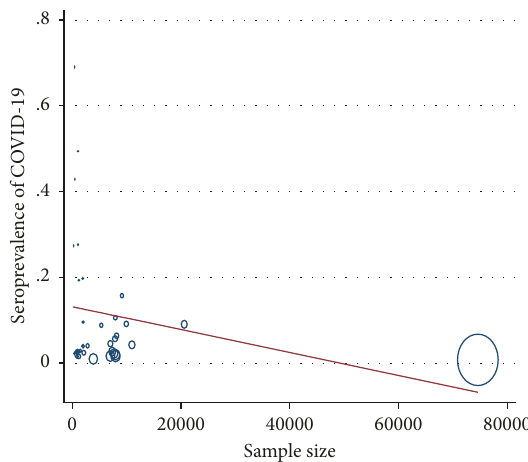
Figure 3: Meta-regression of the relationship between seropre- valence of COVID-19 in blood donors and the sample size.